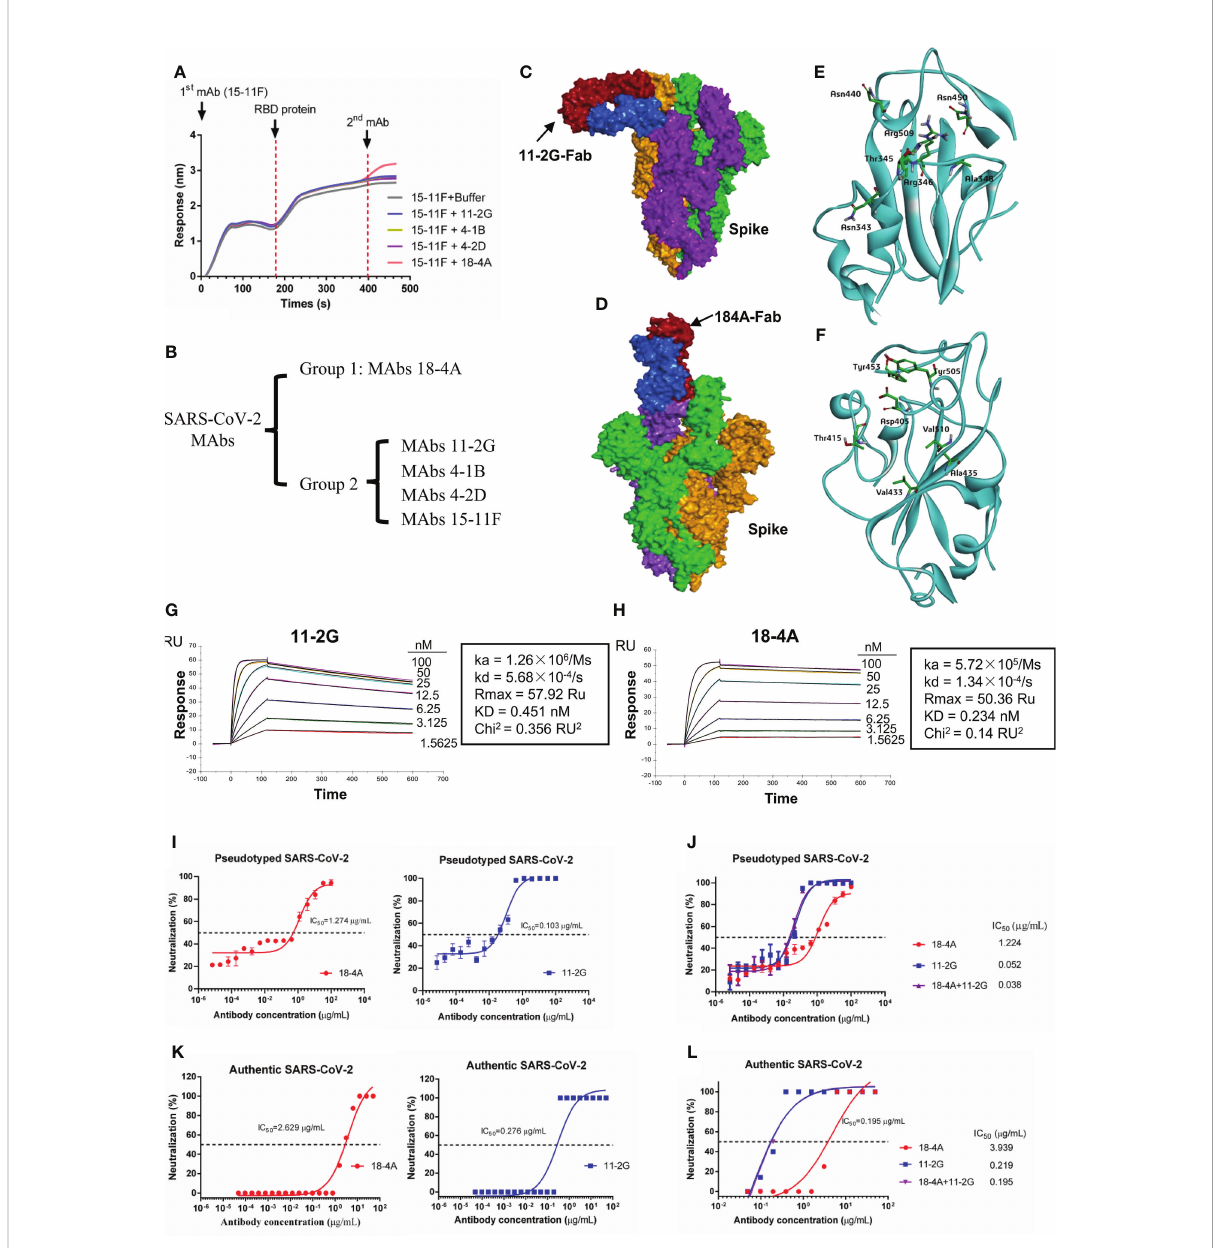
FIGURE 3 Characterization of mAbs against SAR-CoV-2 RBD. (A) Antibody binding competition assay. Immobilized fi rst mAb (30 m g/mL) was mixed with SAR-CoV-2 RBD (51.5 m g/mL), and secondary mAb (30 m g/mL) was used to compete for binding. (B) Grouping of mAbs. Group 1, MAb 18-4A; group 2, the other mAbs. Structural analyses of SARS-CoV-2 spike and Fab complex. (C) Structure of SARS-CoV-2 spike (PDB code: 7TPH) in complex with 11-2G-Fab. (D) Structure of SARS-CoV-2 spike (PDB code: 7TPH) in complex with 18-4A-Fab. The different subunits of the spike protein are colored green, orange, purple; two Fab domains of antibodies are colored blue and red, respectively. Binding details between and SARS-CoV-2 spike and 11-2G-Fab (E) or 18-4A-Fab (F) are presented with amino acids from SARS-CoV-2 spike, which forms hydrophobic or hydrogen bond interactions with amino acids from 11-2G-Fab. (G, H) Analysis of af fi nity of 11-2G and 18-4A for the SARS-CoV RBD protein. (I) Neutralizing activity of 11-2G and 18-4A against SARS-CoV-2 pseudoviruses. (J) Neutralizing activity of 11-2G/18-4A cocktail (1:1) against SARS-CoV-2 pseudoviruses. (K) Neutralizing activity of 11-2G and 18-4A against authentic SARS-CoV-2. (L) Neutralizing activity of 11-2G/18-4A cocktail (1:1) against authentic